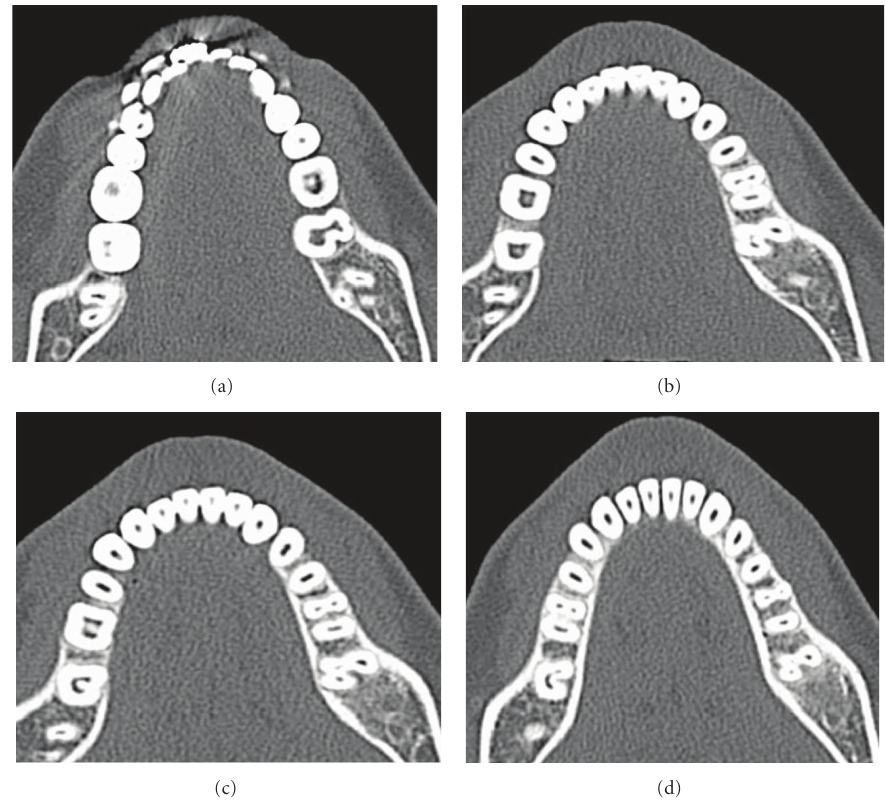
Figure 2: SCT Images of the Maxilla. (a) Axial view of the coronal third section of the roots of the left mandibular left second molar. (b) Axial view of the cervical third section of the roots of the mandibular left second molar. (c) Axial view of the middle third section of the roots of the left mandibular left second molar. (d) Axial view of the apical third section of the crown of the left mandibular left second